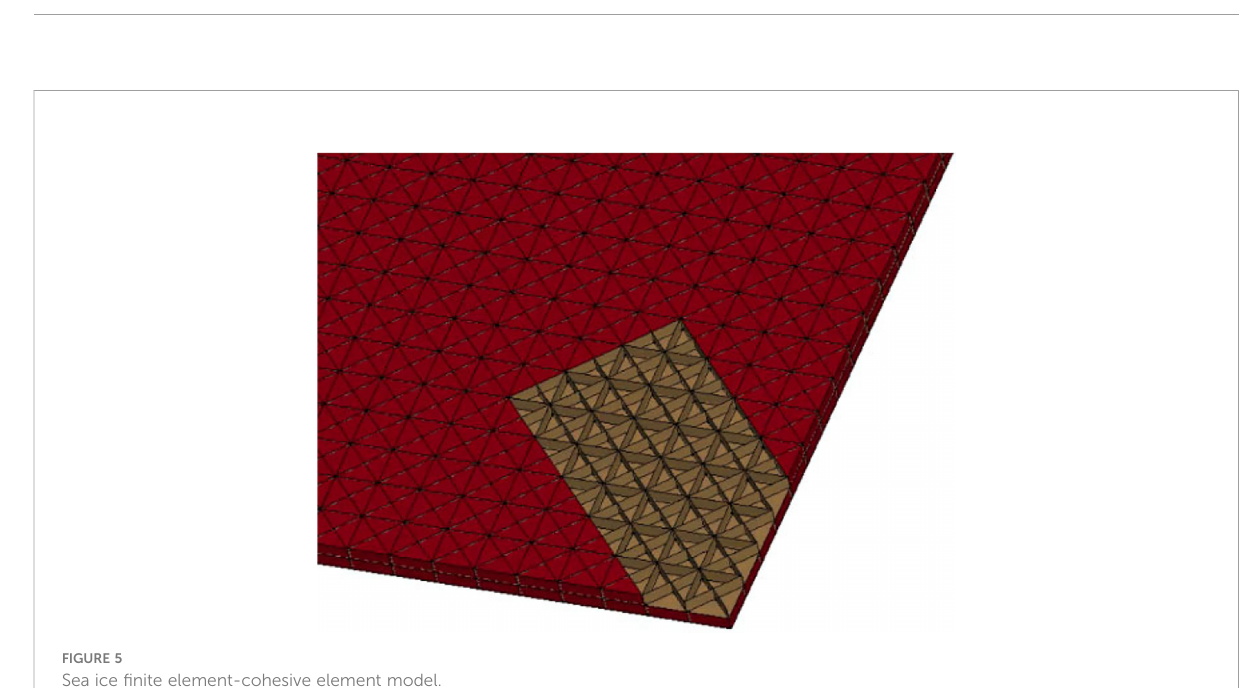
FIGURE 5 Sea ice fi nite element-cohesive element